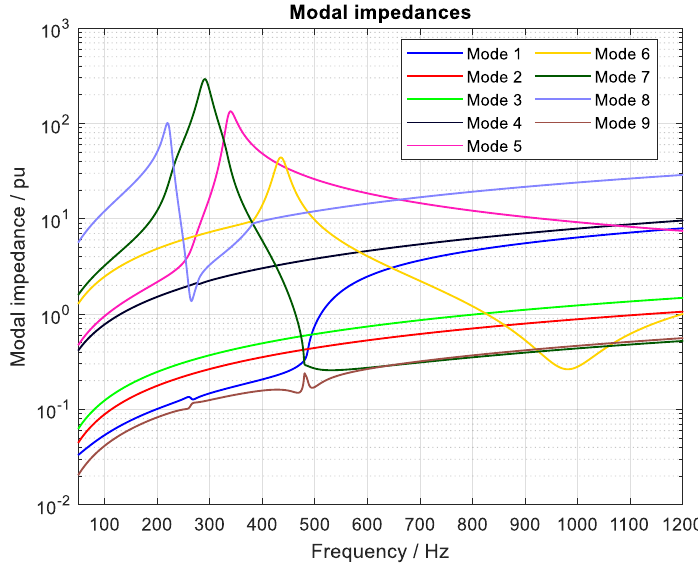
Figure 6. Modal impedances of the industrial system.